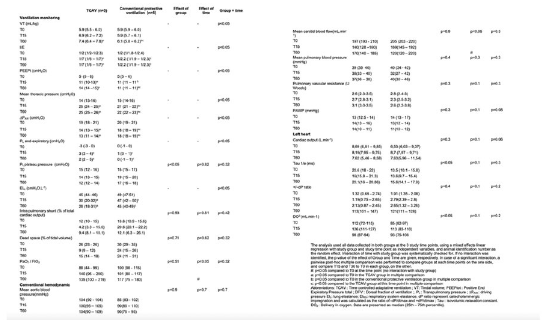
Table of ventilatory and hemodynamics